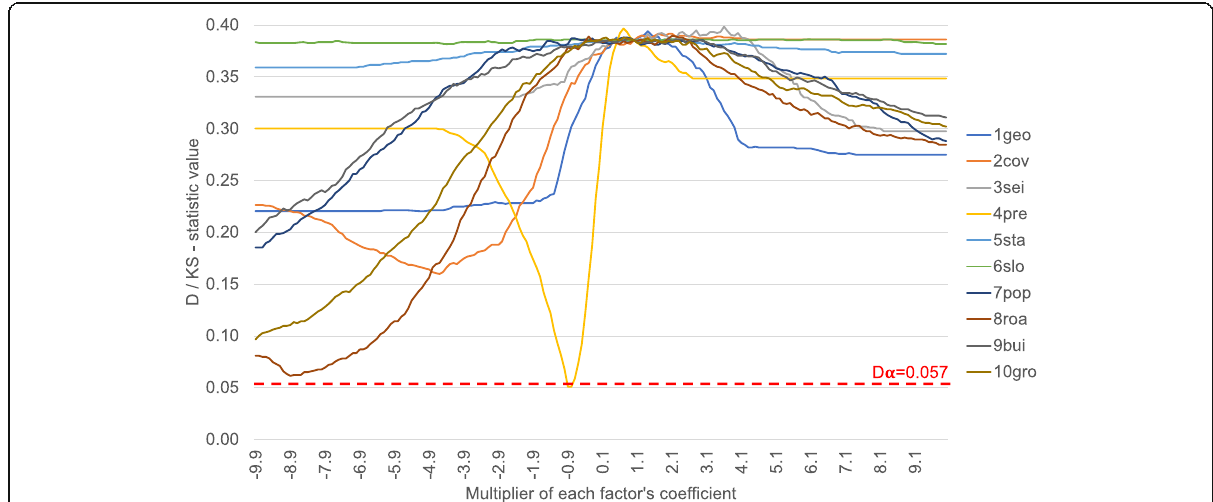
Fig. 9 This shows the D-statistic values of the two-sample K-S test for univariate sensitivity analysis of 2000 simulations, by percentile discretization. Legend: The critical value (D α ), related to an alpha value of 0.05, is marked with the dashed red line. The values below this level (precipitations) represent the non-significant samples from two simulations, whereas the remaining 1998, represented above the line, are considered to be at significance levels. Lines represent factors: 1geo = lithology (electric blue), 2cov = land use/vegetation coverage (orange), 3sei = seismicity (light gray), 4pre = precipitations (yellow), 5sta = soil stability (light blue), 6slo = slope (green), 7pop = population (dark blue), 8roa = road and Y-axis shows the D/KS values